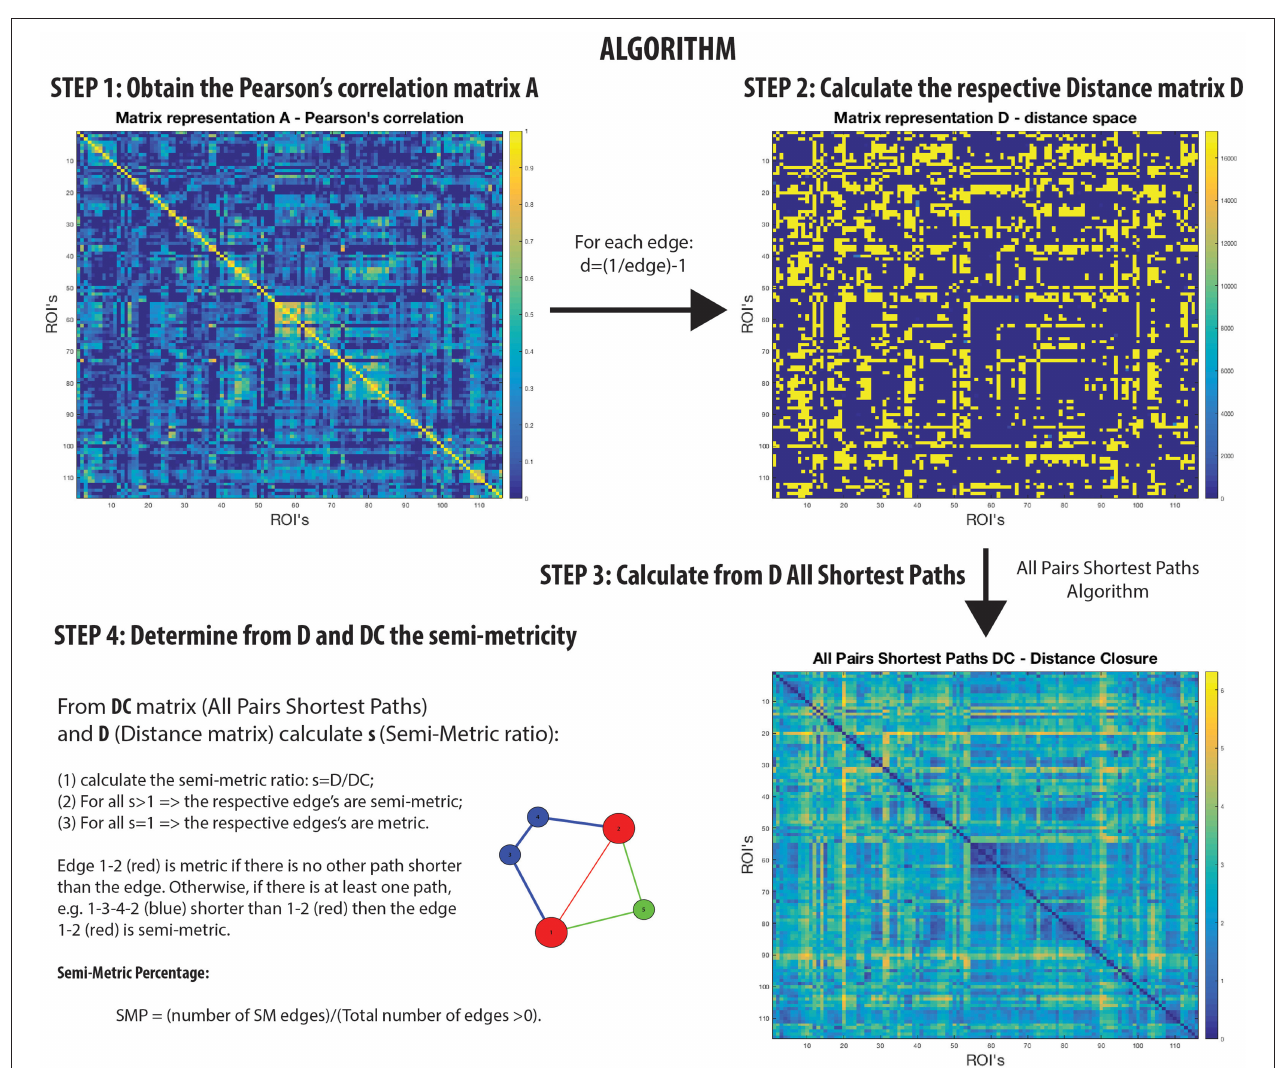
FIGURE 1 | Semi-metric analysis Algorithm on rs-fMRI with Pearson’s